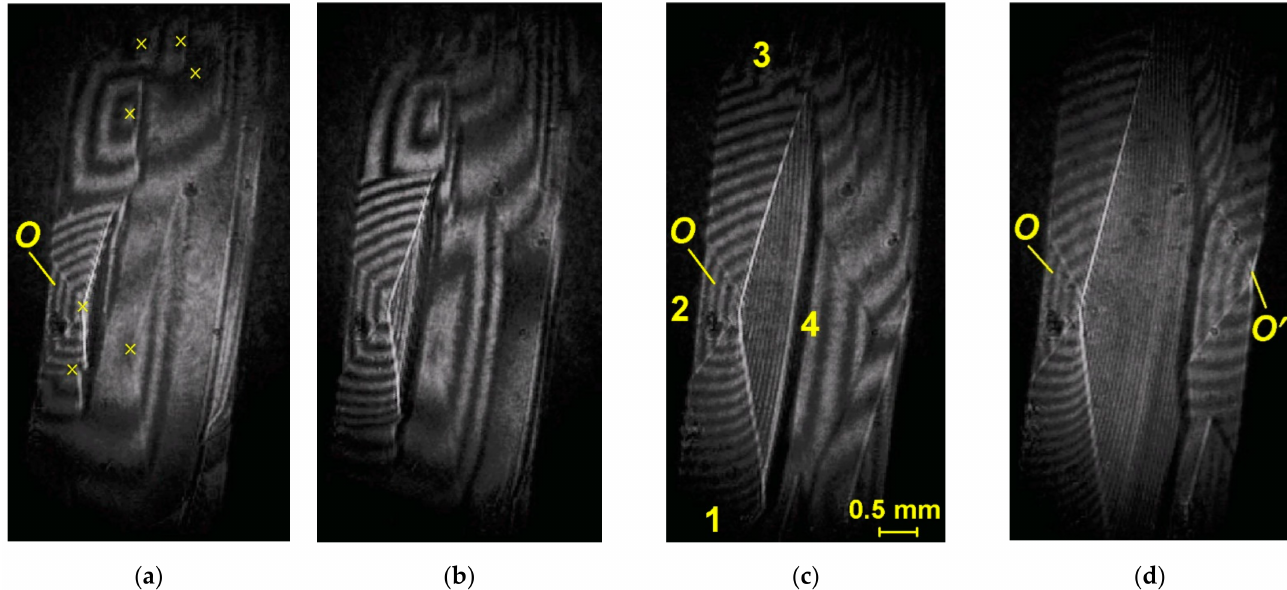
Figure 2. Morphology of the (110) face in 1:2 solution at supersaturations σ ( a ) 0.017; ( b ) 0.021; ( c ) 0.025; ( d ) 0.029. The relief of the surface is mainly formed by the sectors of polygonized growth hillocks and macrosteps. The morphologies of the (110) faces growing in 1:1 and 1:2 solutions look similar, nevertheless the edges between the adjacent sectors of growth hillocks are rounded and smooth in 1:1 solution (Figure 1b) and sharp in 1:2 solutions (Figure